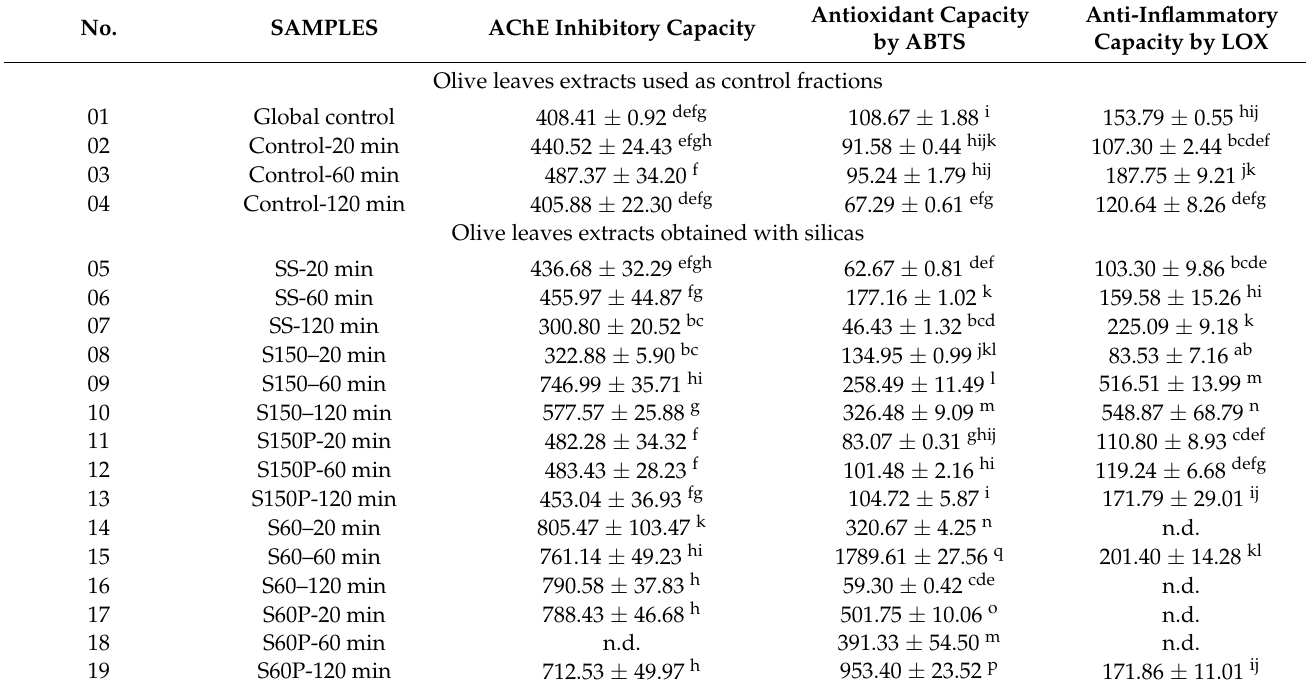
Table 3. IC 50 values ( µ g/mL) for AChE, ABTS • + , and LOX assays obtained for the 32 olive leaves extracts and reference- standards